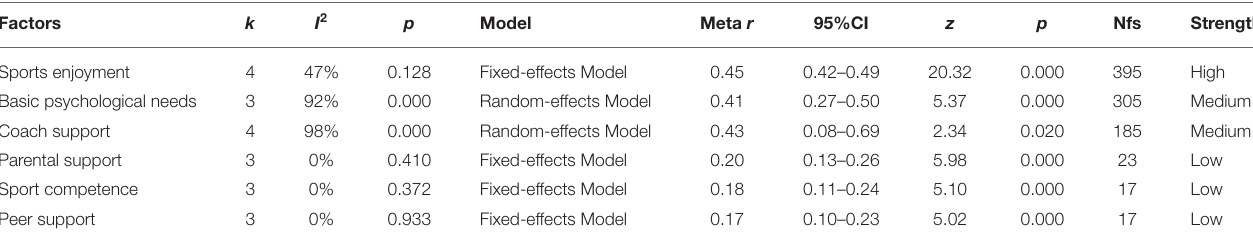
TABLE 5 | Meta-Analysis of factors related to persistent participation